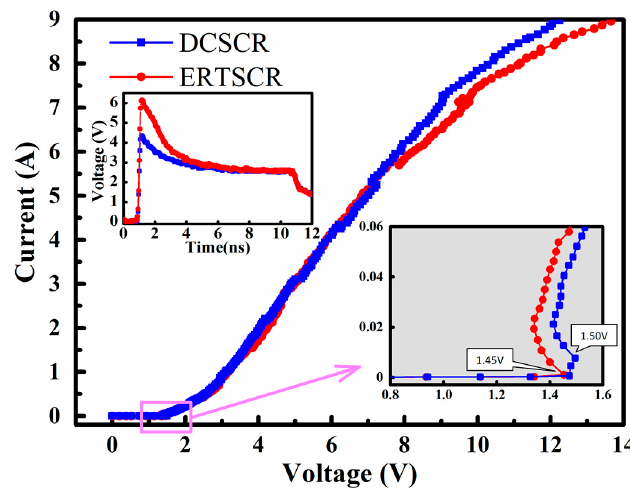
Figure 7. Measured VF-TLP I-V curves and transient voltage waveforms of conventional DCSCR and proposed ERTSCR.